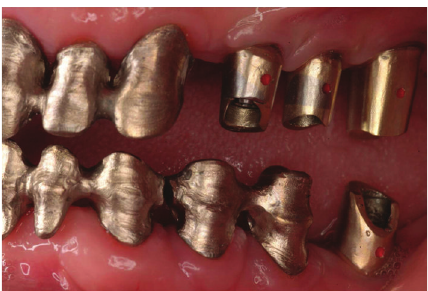
Figure 36: Final framework and ceramization were performed with the cross-mounting